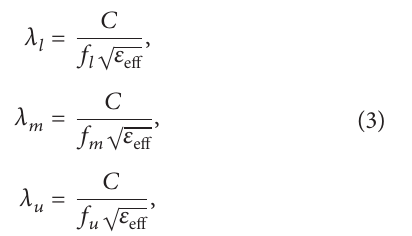
the inner branch and the circular patch, and 𝐿 − 𝑊 2 /2 is the distance between the outer branch and the circular patch. 𝜆 𝑙 , 𝜆 𝜆 𝑚 , and 𝑢 are the lower, middle, and upper wave length, respectively. They are given